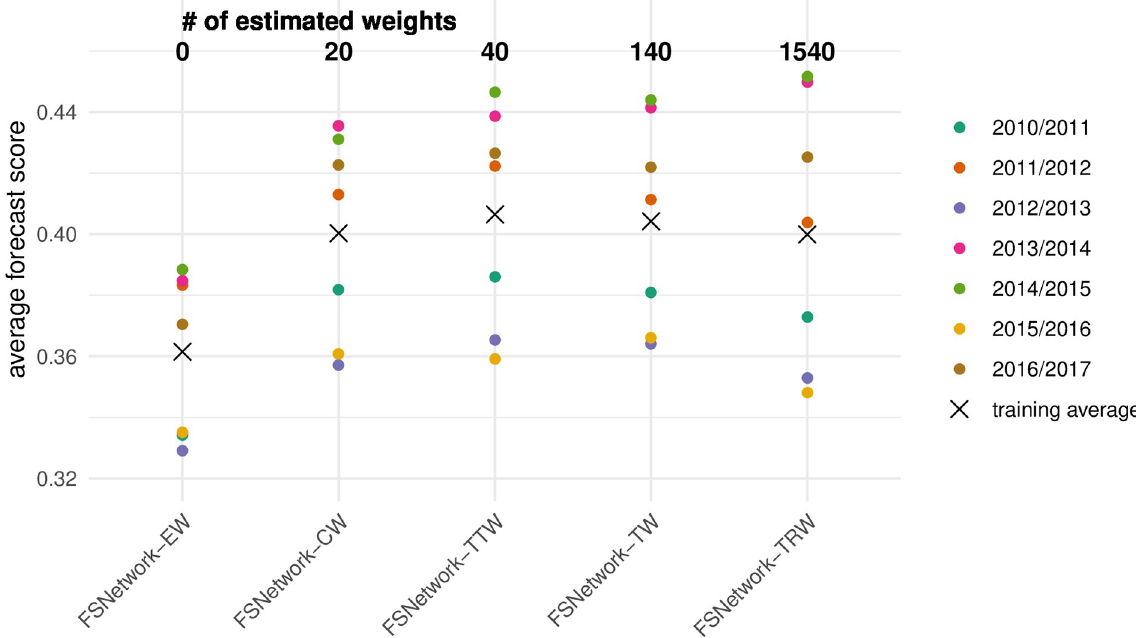
Fig 2. Training phase performance of the five pre-specified multi-model ensembles. The five ensembles tested were Equal Weights (EW), Constant Weights (CW), Target-Type Weights (TTW), Target Weights (TW), and Target-Region Weights (TRW). The models are sorted from simplest (left) to most complex (right), with the number of estimated weights (see Methods) for each model shown at the top. Each point represents the average forecast score for a particular season, with overall average across all seasons shown by the